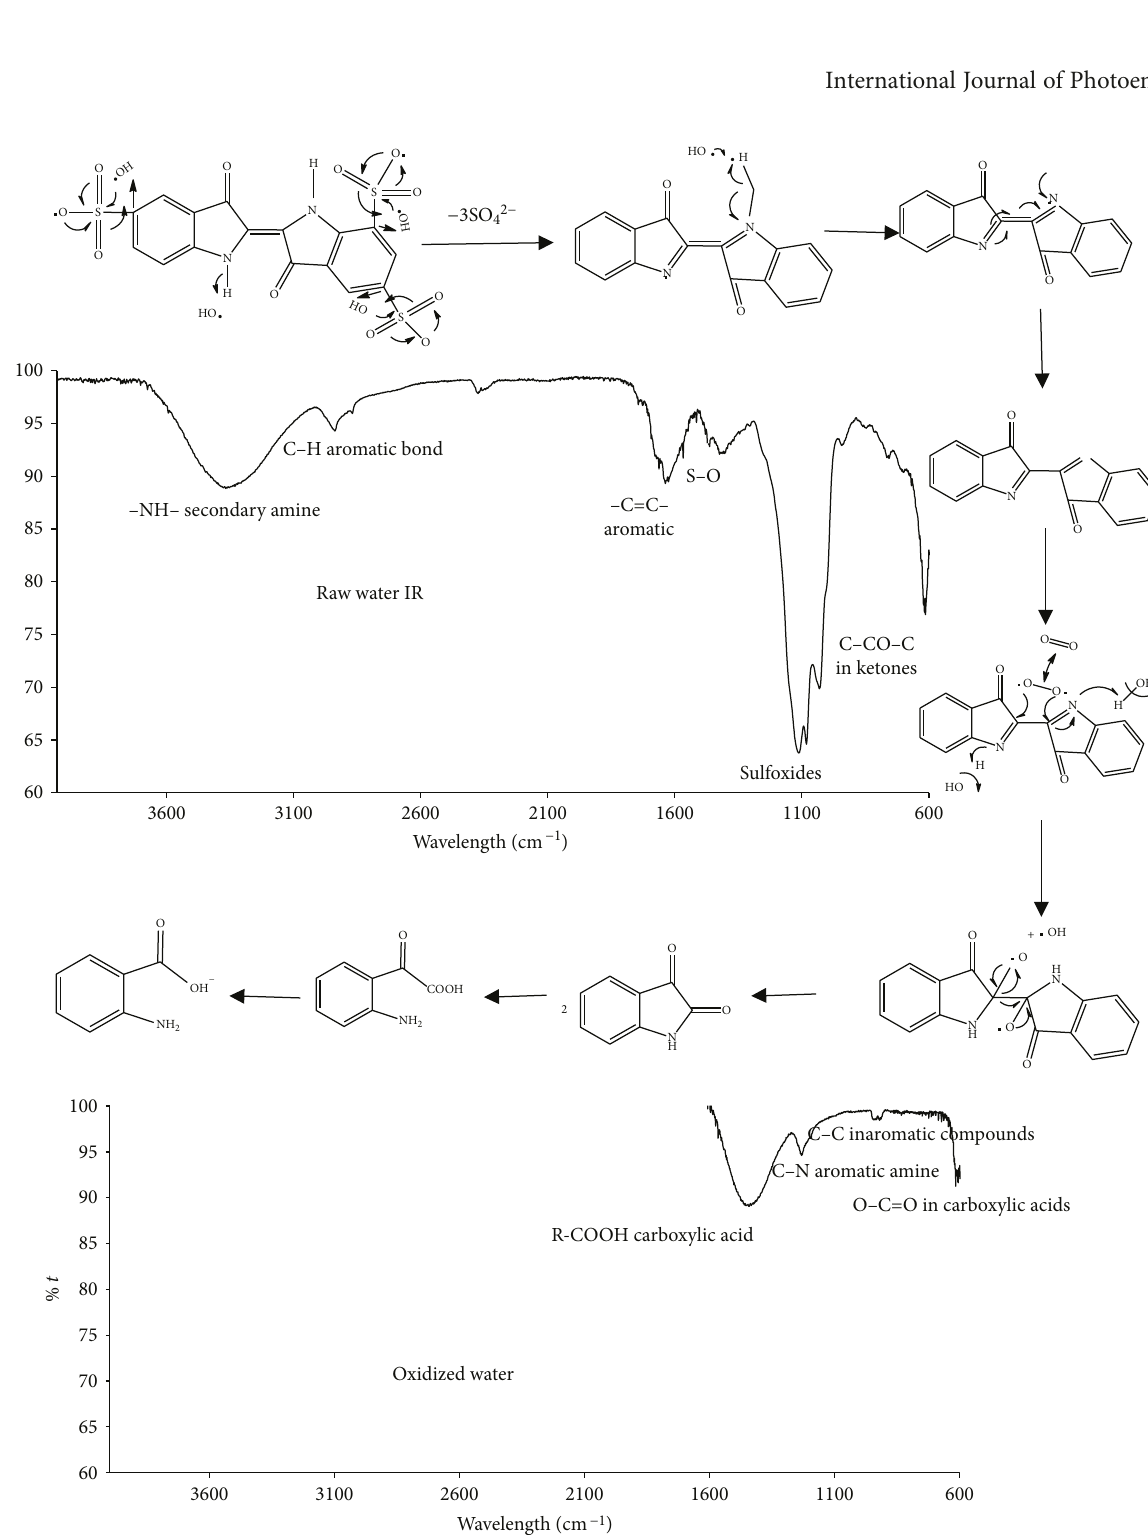
Figure 6: Diagram of the degradation mechanism proposed. Within the fi gure are shown the infrared spectra of raw water and oxidized